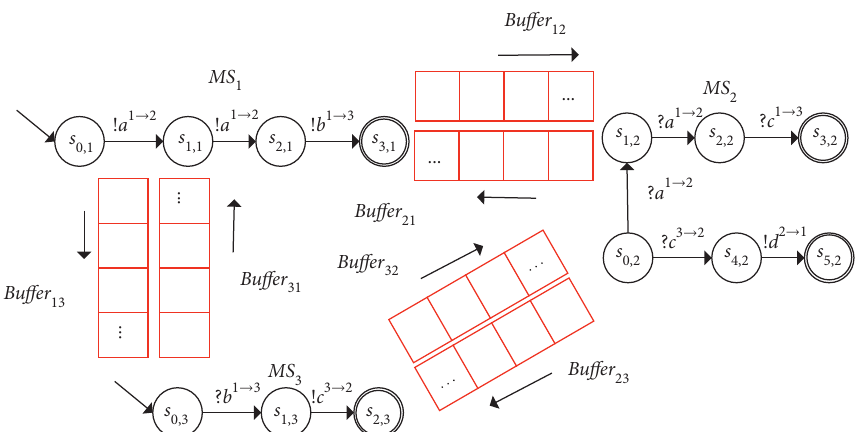
Figure 1: The formal model of complex interactions in microservice systems under the peer-to-peer communication.